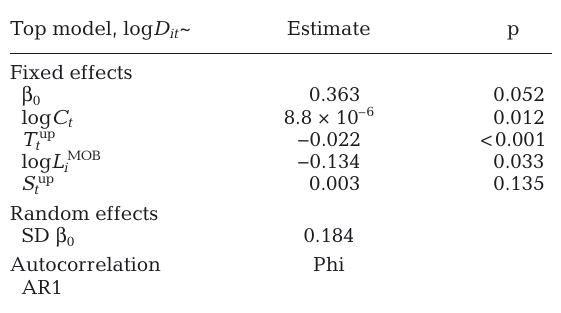
Table 3. Analysis of Salmo trutta swimming depth ( D it ) . Top model from model selection 1 (Table S2a in the Supplement), where β 0 is the intercept, C t is surface light intensity, T t up is surface temperature (0.2 m), S t up is surface salinity (0.2 m), and L i MOB is mobile lice per gram of fish. i : variation in the factor across individuals; t : variation across time; SD: stan- dard deviation; Phi: correlation coefficient. AR1 is the same autocorrelation structure as described in section